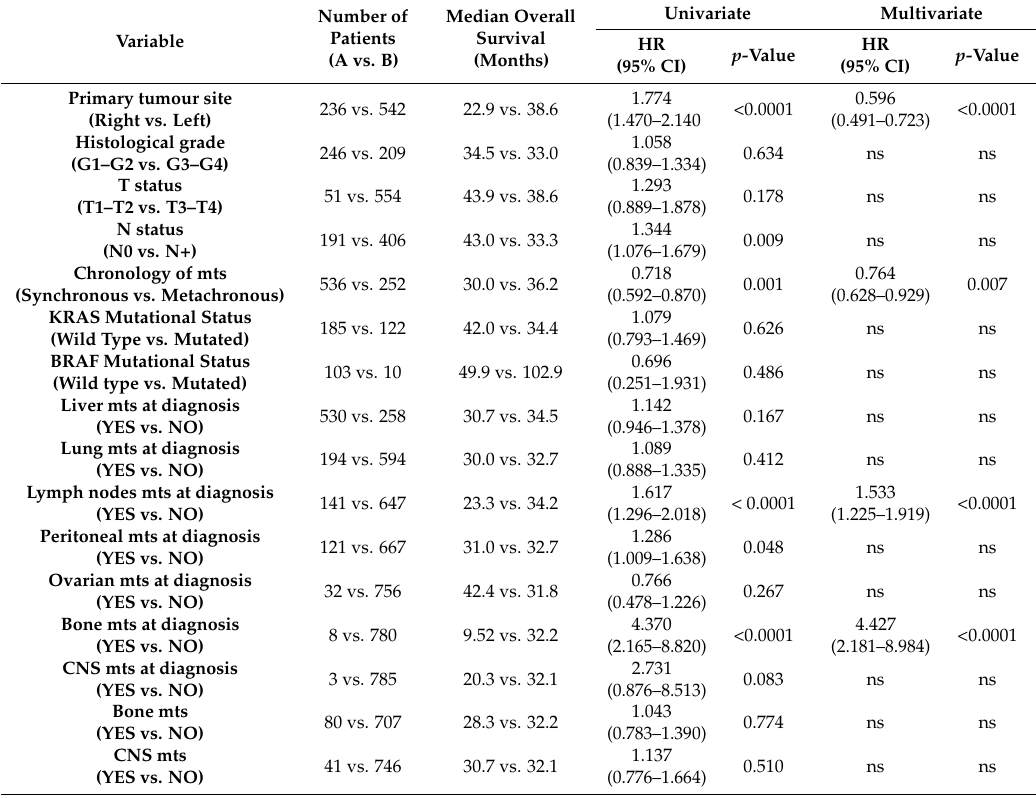
Table 5. Univariate and multivariate analysis. CI—confidence interval.